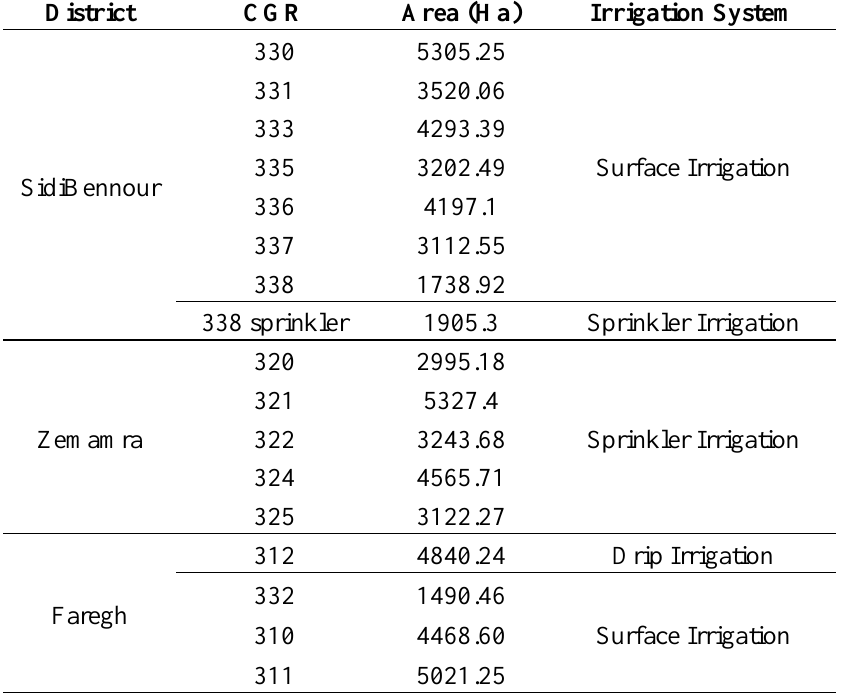
Table 1. Irrigation Systems in different Centers of Irrigation Management (CGRs) in three districts of the Doukkala Irrigation Scheme (ORMVAD-personal